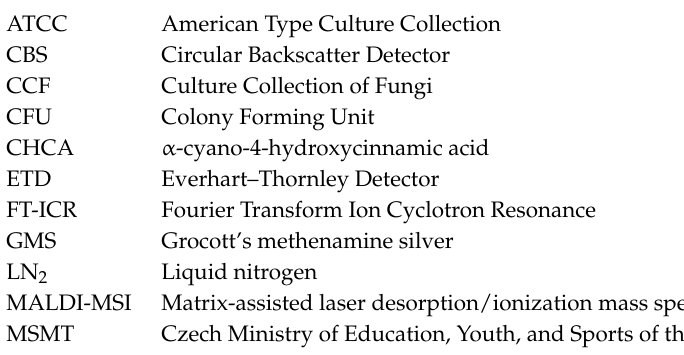
Figure S1: Stereo images (R-GB anaglyphs) of float-fixed cryosection from rat lung tissue infected with A. fumigatus . Figure S2: A comparison of scanning electron microscopy and histology of Aspergillus fumigatus infected rat lung tissue. Figure S3: Scanning electron microscopy of Pseudomonas aeruginosa infected rat lung tissue and exact localization of the areas from which high-resolution images were